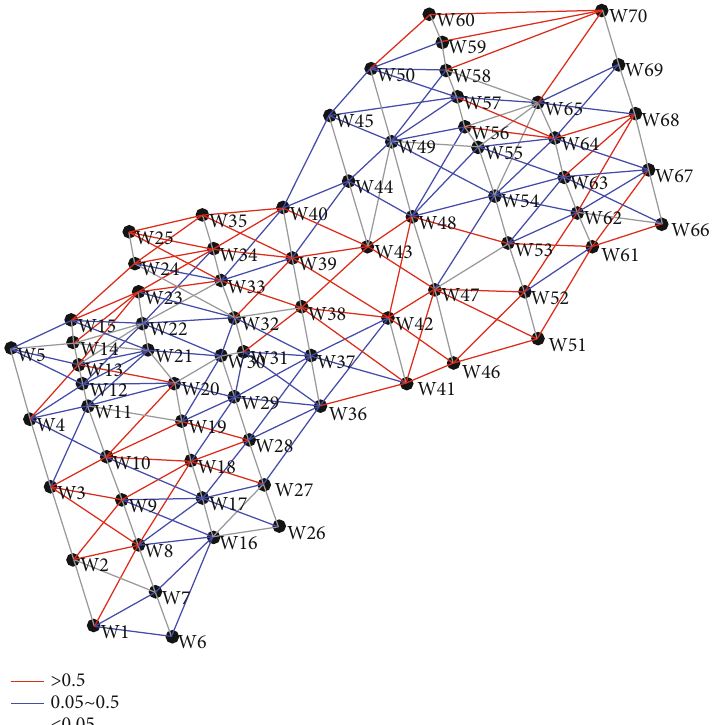
Figure 11: Distribution of interwell transmissibility.